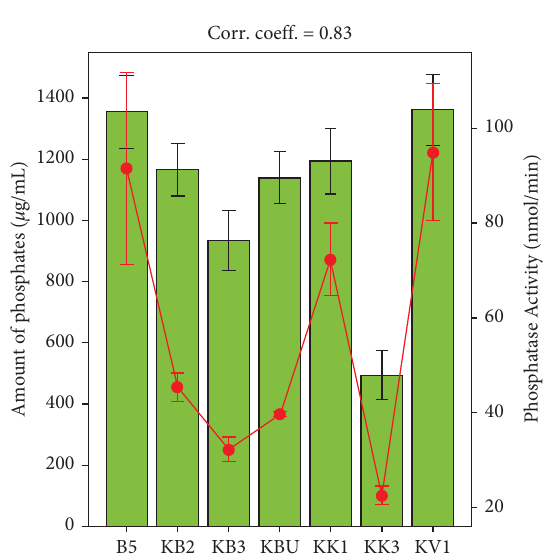
Figure 3: Amount of solubilized phosphorus in μ g/mL and phosphatase enzyme activity in